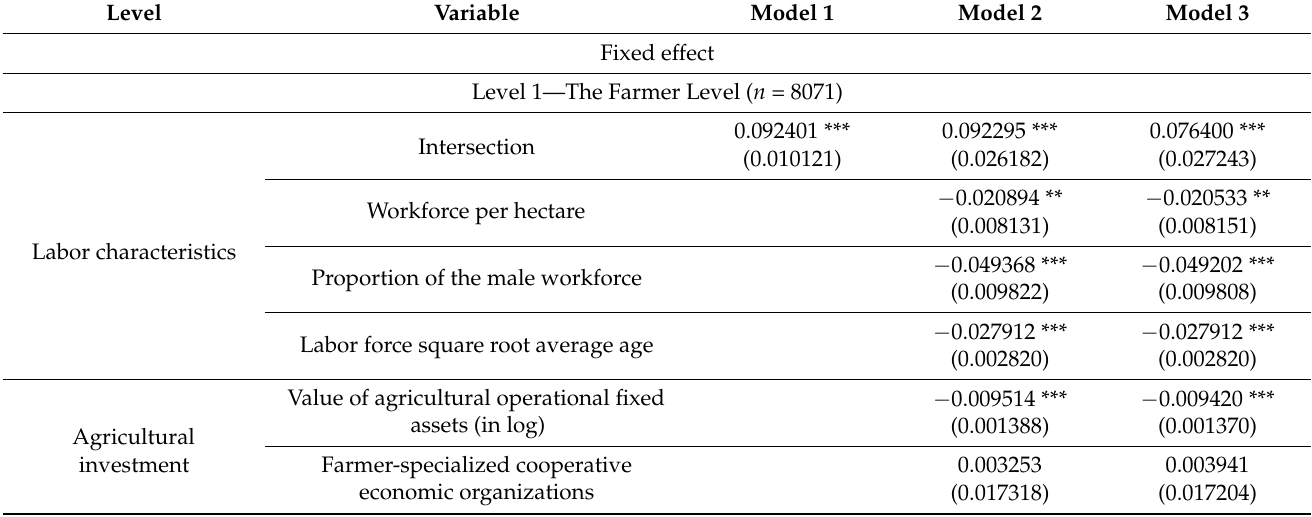
Table 2. Multi-level model of degrees of cropland